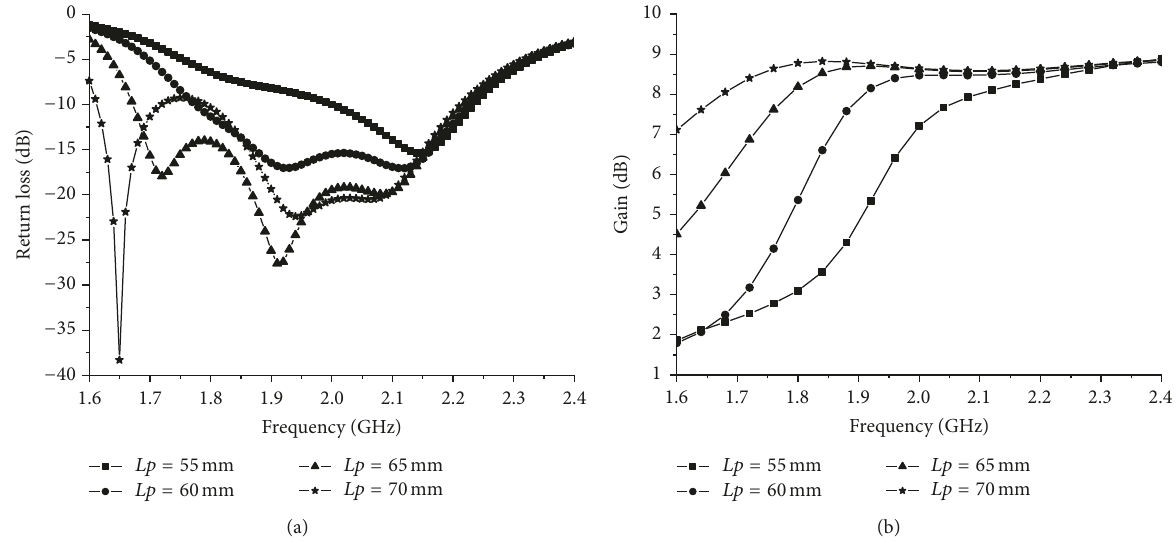
Figure 10: Effect of the width of the lower patch 𝐿𝑝 . (a) Return loss. (b) Antenna gains.